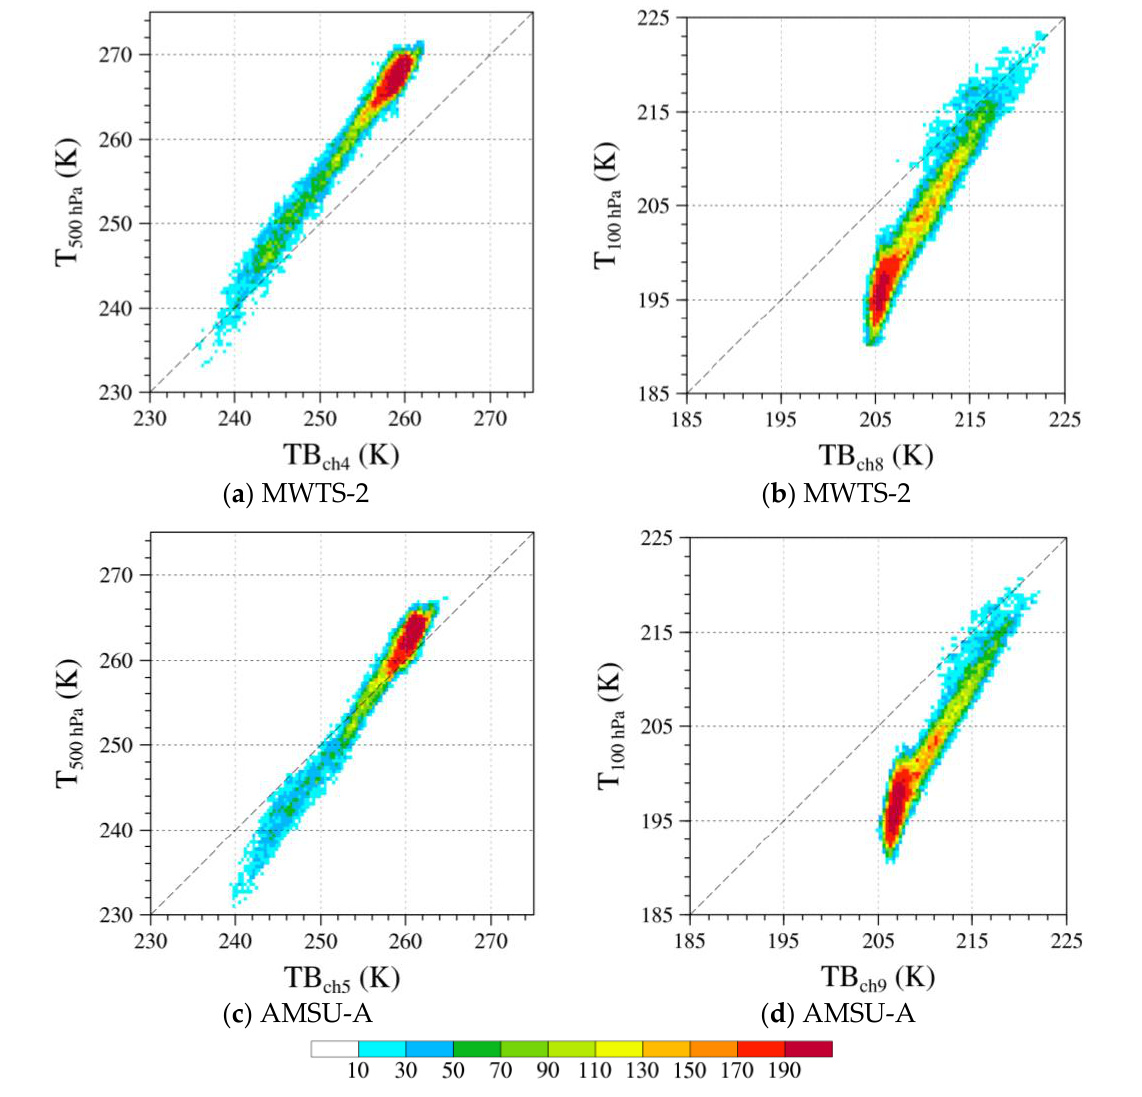
Figure 5. Data counts within each 0.5 K × 0.5 K box to show the correlations between ( a , b ) brightness temperature observations and ERA-5 temperatures: ( a ) FY-3D MWTS-2 channel 4 versus ERA-5 500 hPa; ( b ) FY-3D MWTS-2 channel 8 and ERA-5 100 hPa; ( c ) MetOp-B AMSU-A channel 5 and ERA-5 500 hPa; and ( d ) MetOp-B AMSU-A channel 9 and ERA-5 100 hPa for all clear-sky nadir oceanic data during the time period from 10 to 31 July 2019. The correlations R values are shown for a linear regression between the ERA-5 temperatures and brightness temperatures.